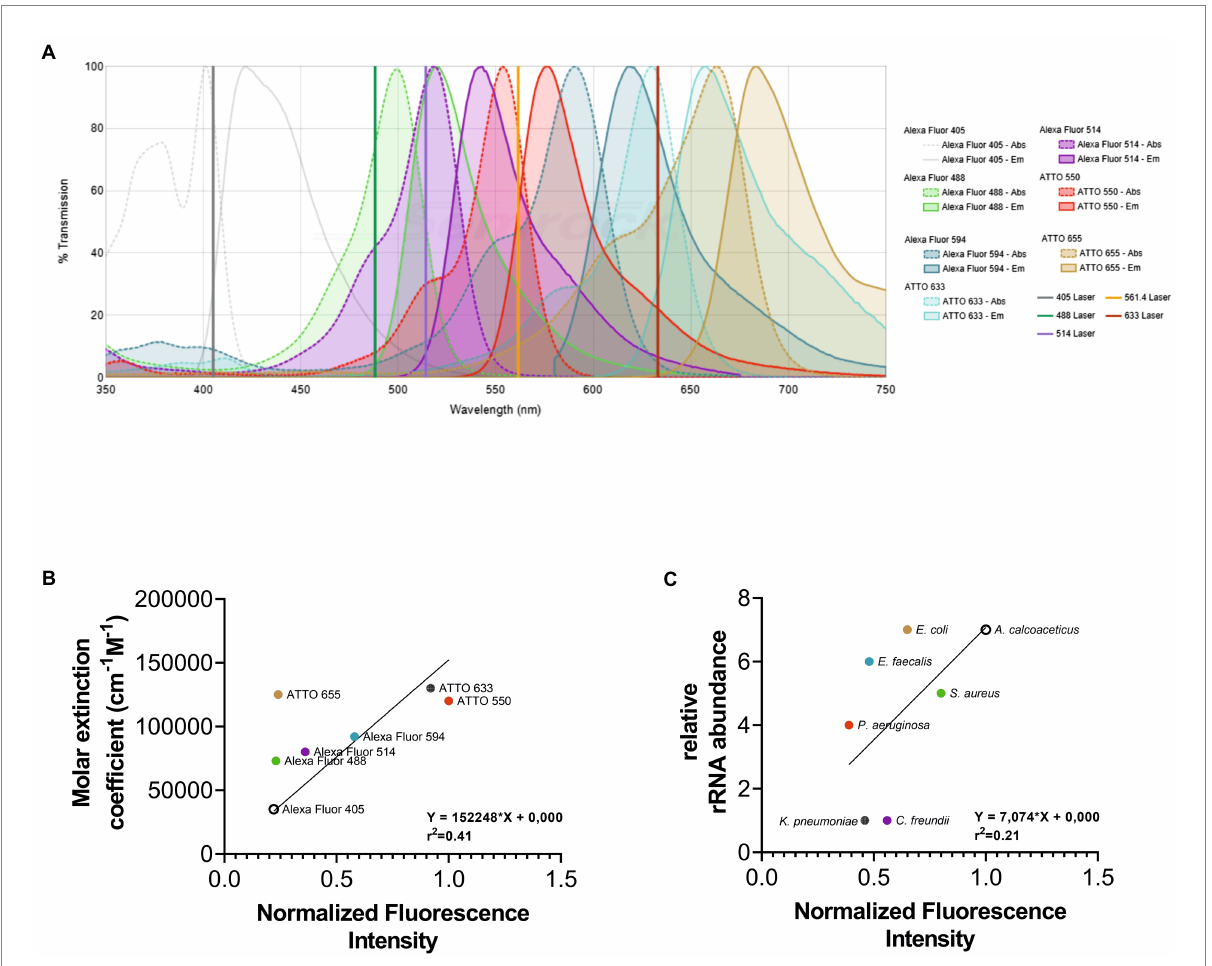
FIGURE 1 Representation of emission and excitation spectra of fluorochromes selected for this study. The fluorochromes selection was made according to their spectral properties and the filter setup of the fluorescence microscope to be used. As observed in (A) the emission spectra present a certain degree of the overlapping since the imaging strategy used in this methodology is based on the discrimination of the emission spectra of fluorochromes applying linear unmixing. To help on the selection of fluorochromes, the “SearchLight Spectra Viewer” from “Semrock” database (https://searchlight.semrock.com) was used. The normalized fluorescence intensity of each fluorochrome (B) and bacterium (C) was correlated with the molar extinction coefficient and the relative rRNA abundance, respectively. The fluorescence signal intensity of each image was determined using Fiji software. The molar extinction coefficient was obtained from data available by fluorochromes companies. The relative rRNA gene abundance of each bacterium was obtained on Greengenes